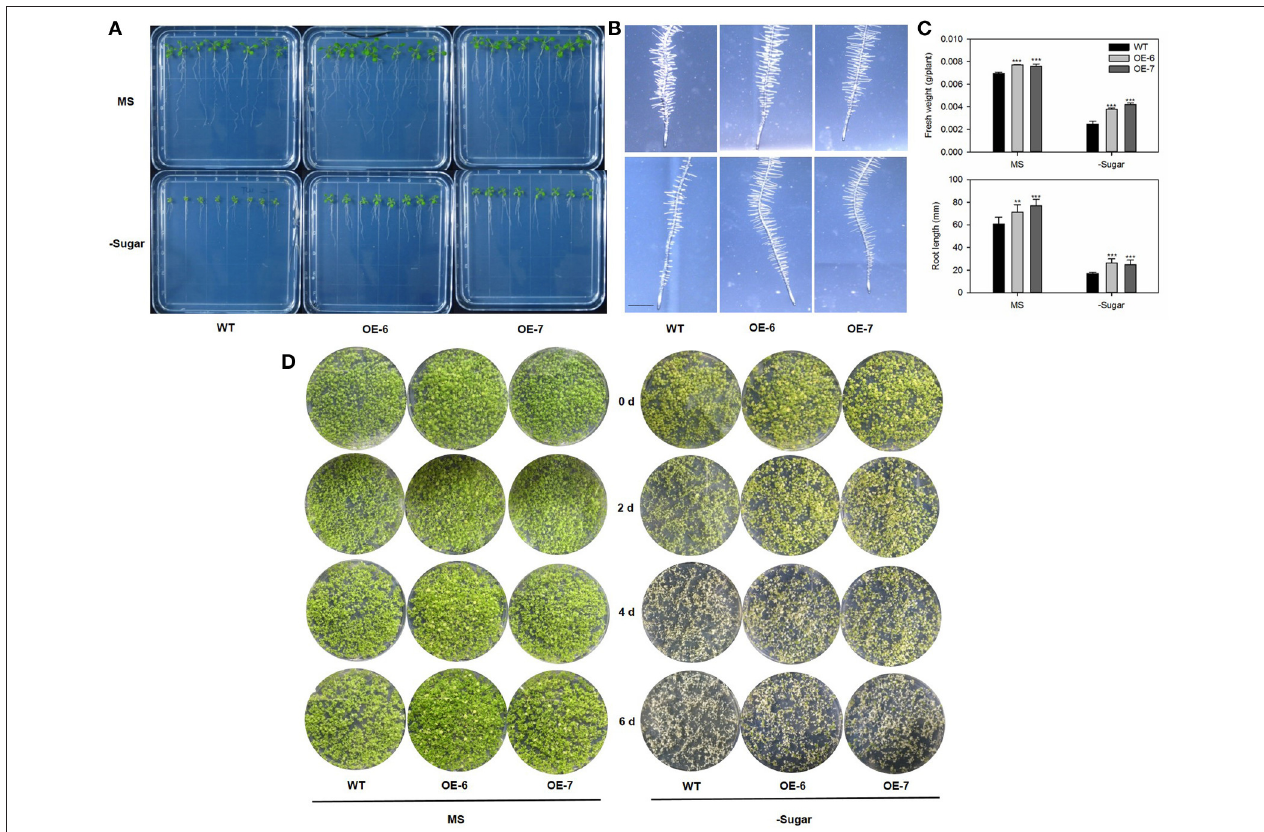
FIGURE 9 | Results of analysis using plants to test tolerance to carbon-starvation, which is enhanced by heterologous expression of MdATG8i . Seven-day-old Arabidopsis seedlings were transferred to standard MS or sugar-depleted agar media. After incubation in dark for 10 days, plates were returned to light for recovery under LD photoperiod. (A) Seedling phenotypes for WT and OE lines; (B) Root hair phenotype; scale bar = 5 mm; (C) Fresh weights and root lengths. Data are means ± SD of 15 replicates; (D) Alternative analysis using seeds to test tolerance to carbon-starvation. Arabidopsis seeds were germinated and grown on MS solid medium with or without 1% sucrose for 14 days. Afterward, plates were incubated in dark for another 14 days. Plants from WT and OE lines were photographed on alternate days (0, 2, 4, 6) to monitor recovery phenotype under LD photoperiod. * , ** or *** indicates the statistically significant differences determined by Student’s t -tests at P < 0.05, P < 0.01, or P < 0.001,